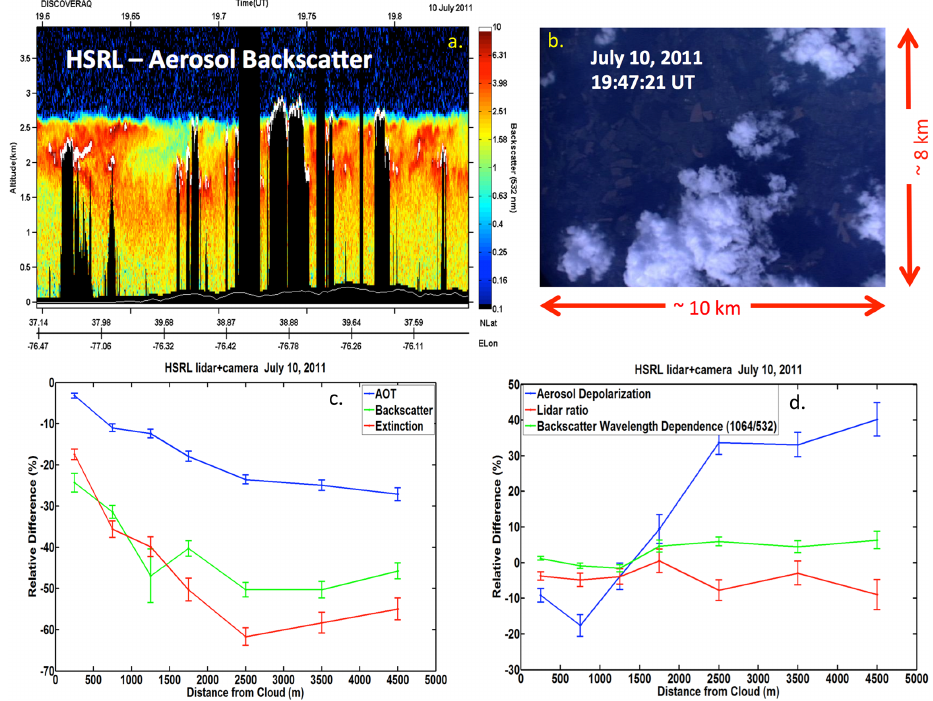
Figure 10. (a) Downward viewing HSRL measured backscattering coefficient (532nm) from a 15min flight segment corresponding to a ∼ 90km transect on 10 July 2011 in the Maryland study region. (b) An example digital camera image taken coincident with the HSRL data in order to determine the distance from cloud of each lidar scan pulse. (c) Aerosol extensive parameters (backscatter, extinction, and AOD) inferred from HSRL data as a function of distance from the cloud edge. (d) Aerosol intensive parameters (depolarization, lidar ratio, and backscatter wavelength dependence) inferred from the HSRL data as a function of distance from the cloud